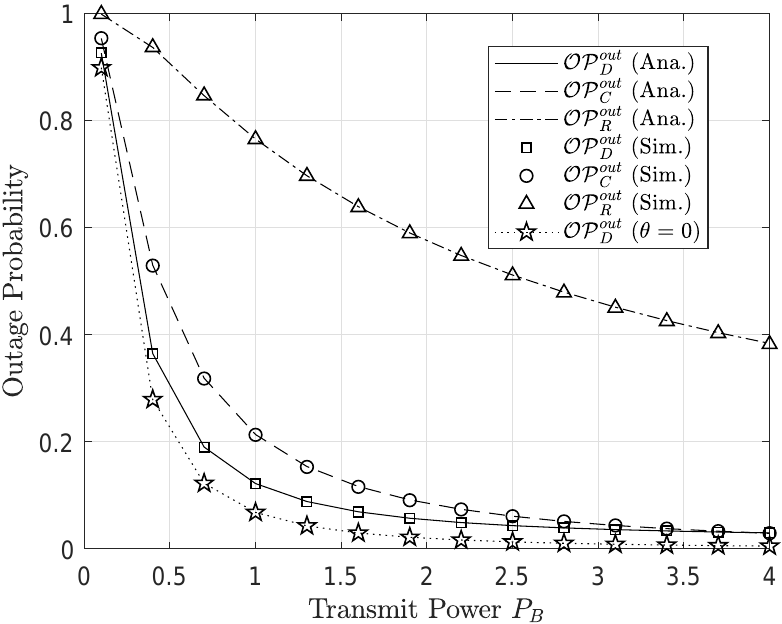
Figure 6. Outage performance versus transmit power ( P B ) at the base station.